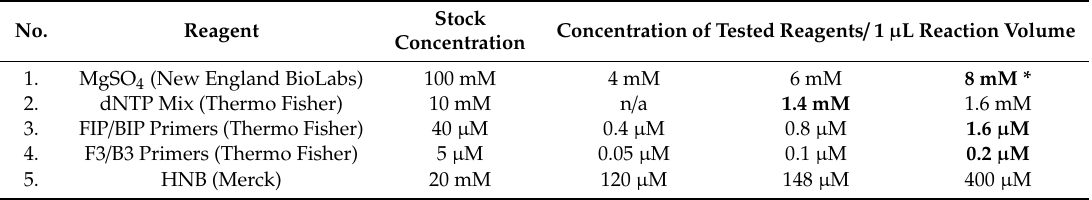
Table 2. Standardization of reagents used in LAMP